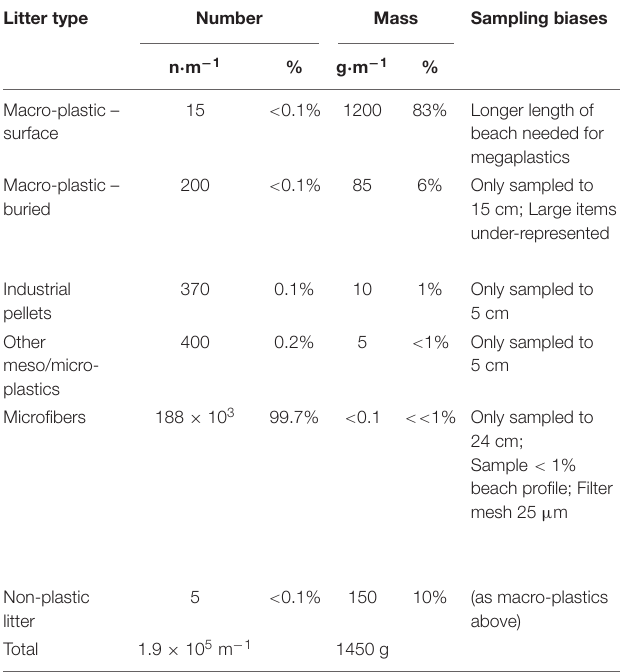
TABLE 5 | Estimated numbers and masses of macro-, meso-, and micro-litter per meter of beach in the West Coast National Park, South Africa, combining data from 2010 (macro-litter), 2017 (micro-litter) and both years combined